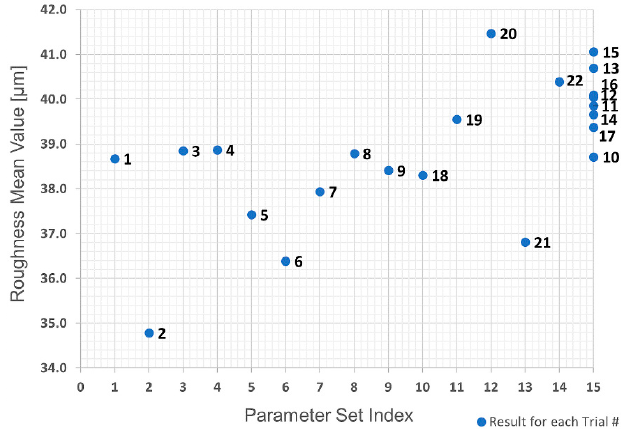
Figure 21. Replicate plot: average roughness for each trial number.